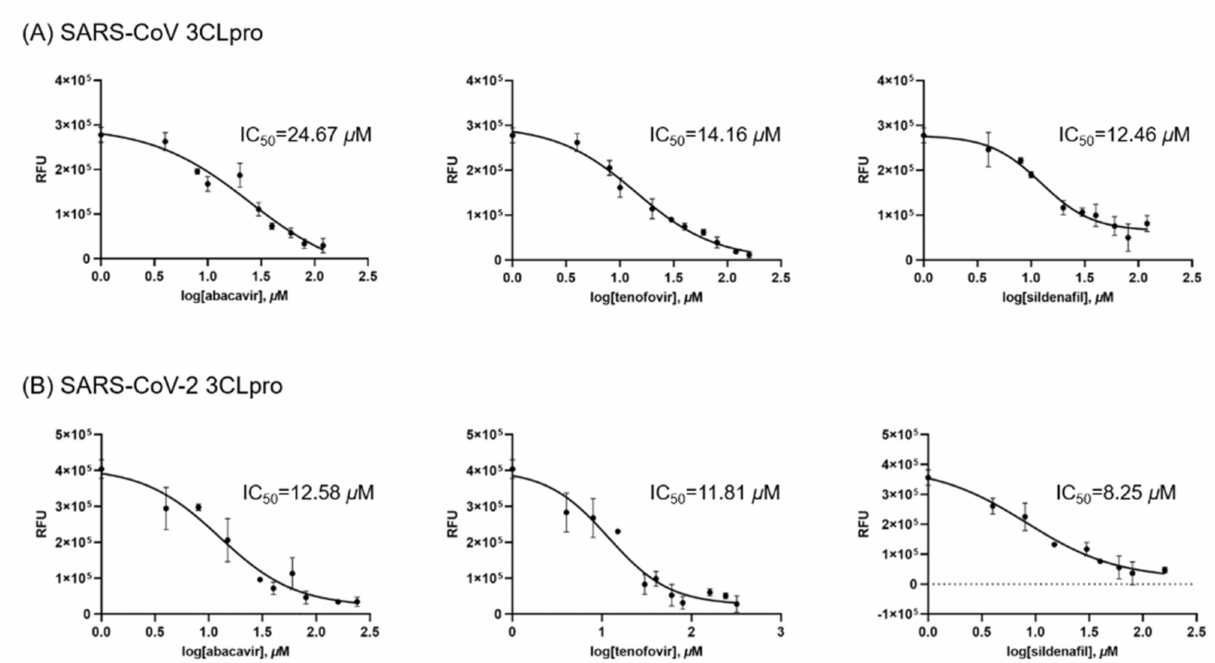
Figure 2. Results from the FRET method. Each data point represents the effect of each inhibitory compound against ( A ) SARS-CoV 3CLpro and ( B ) SARS-CoV-2 3CLpro, compared to the control. The RFU are plotted against the log- concentration of inhibitory compounds. Each dot is expressed as the mean ± standard error of the mean (n = 3). RFU = Relative Fluorescence